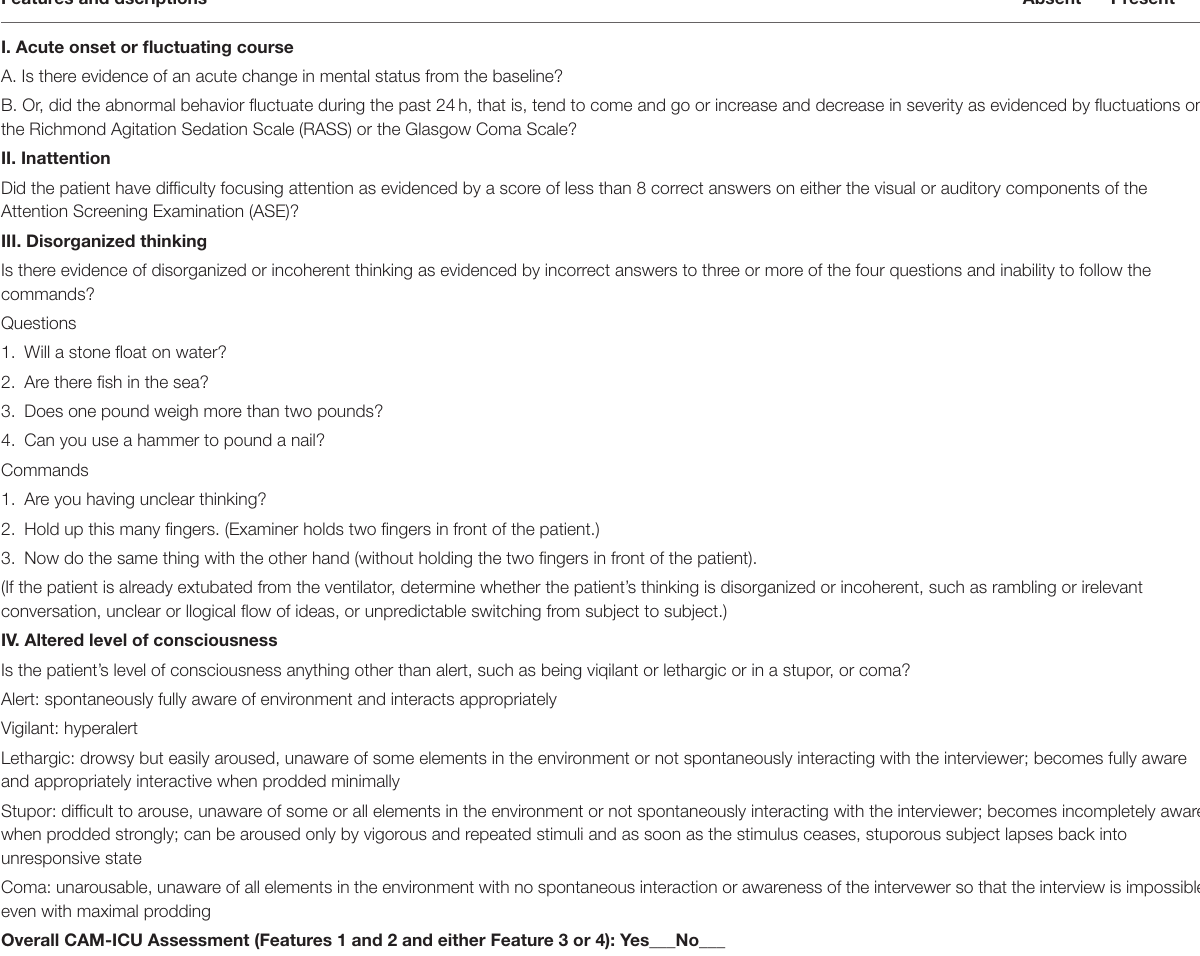
TABLE 3 | The confusion assessment method for the intensive care unit